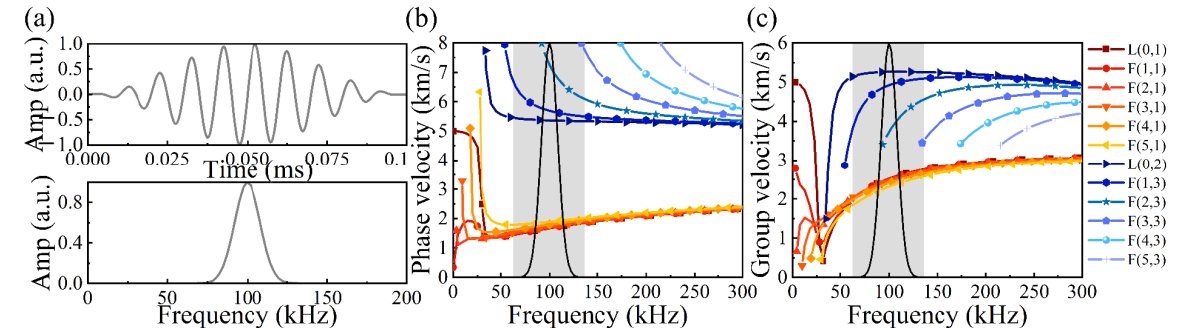
Figure 2. ( a ) Excitation signals in time and frequency domains, and dispersion curves of non-axisymmetric UGWs: ( b ) phase velocity and ( c ) group velocity.